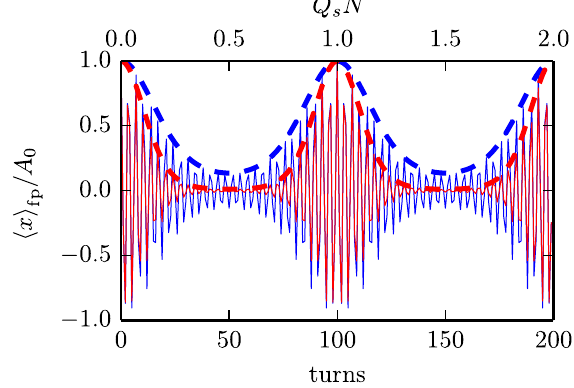
FIG. 1. Time evolution of the beam offset after the transverse kick from particle tracking simulations with the fixed-position 0 . 01 . Red lines are for δ Q 0 . 01 and monitoring for Q ξ ¼ s ¼ δ Q 0 . 015 , blue lines are for δ Q 0 . 005 and δ Q 0 . 01 ξ ¼ eff ¼ eff ¼ ( ξ < 0 and η < 0 ). The solid lines are the bunch offsets and the dashed lines are given by Eq. (1) with the effective tune spread from Eq.